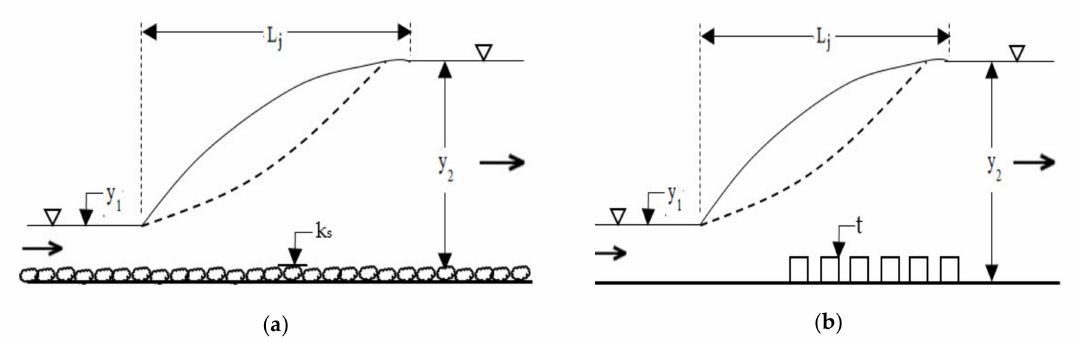
Figure 1. Sketches of hydraulic jump over the rough bed: ( a ) natural rough bed and ( b ) artificial rough